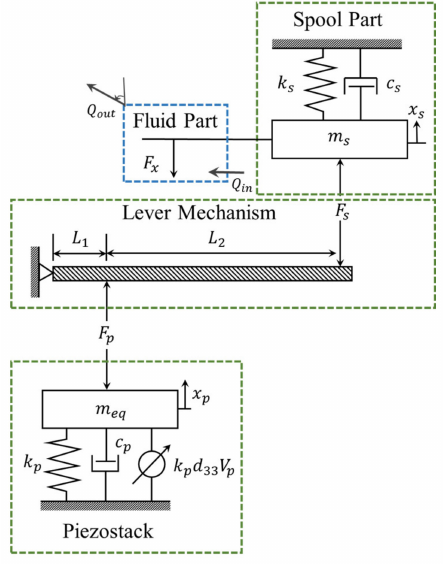
Figure 2. Mechanical model of